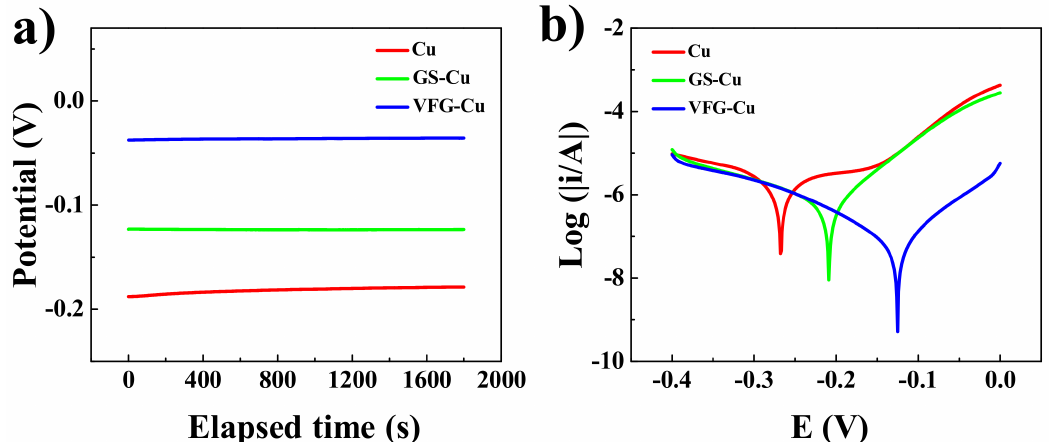
Figure 4. ( a ) Open circuit potential curves for Cu, GS-Cu, and VFG-Cu. ( b ) Tafel plots for Cu, GS-Cu, and